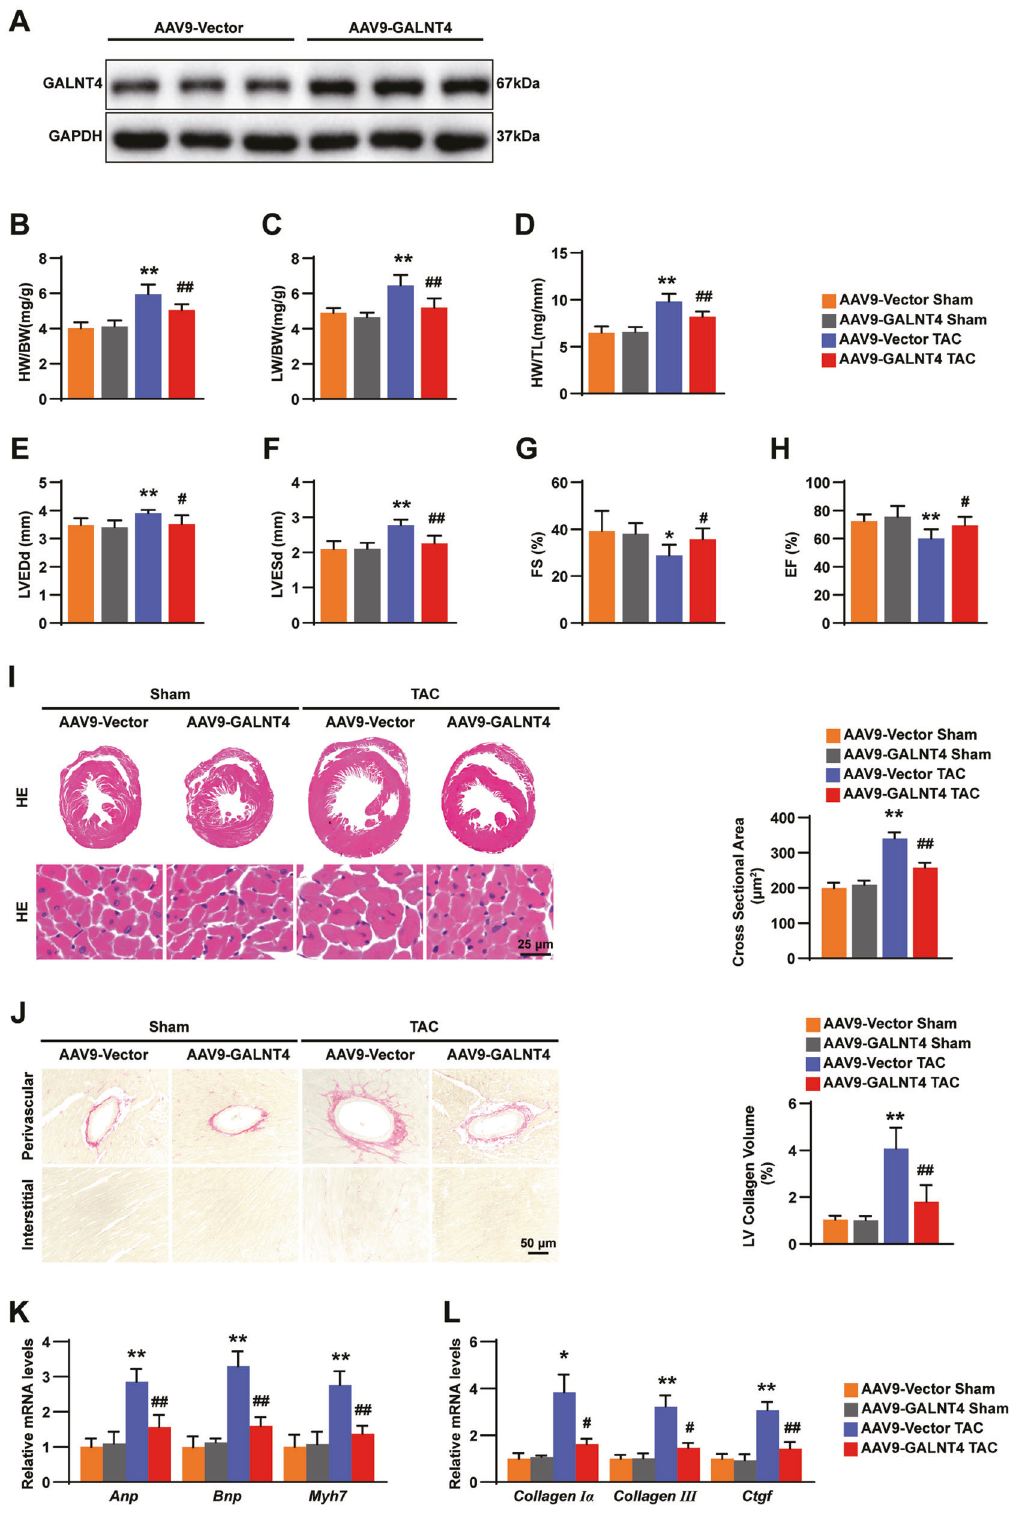
Fig. 4 Cardiomyocyte-speci fi c overexpression of GALNT4 attenuates the cardiac hypertrophy induced by TAC surgery. A The levels of GALNT4 in AAV9 – GALNT4, AAV9-Vector mice were analyzed by western blotting. B – D The ratio of HW/ BW, LW/BW, and HW/TL in the AAV9- GALNT4 group and sham group ( n = 10 mice per group). E – H LVEDd, LVESd, EF%, and FS% were analyzed in each group ( n = 10 mice per group). I H&E staining images ( n = 6 mice per group) and heart CSA ( n = 120 cells in each group) in AAV9 – GALNT4 and control mice. J Images of PSR staining (left, n = 6 mice per group) and percentage of LV collagen volume in the indicated group. L , M The levels of markers of hypertrophy and fi brosis were analyzed by qPCR ( n = 4 mice per group). * p < 0.05 vs. AAV9-Vector sham, ** p < 0.01 vs. AAV9-Vector sham, # p < 0.05 vs. AAV9-Vector TAC, ## p < 0.01 vs. AAV9-Vector